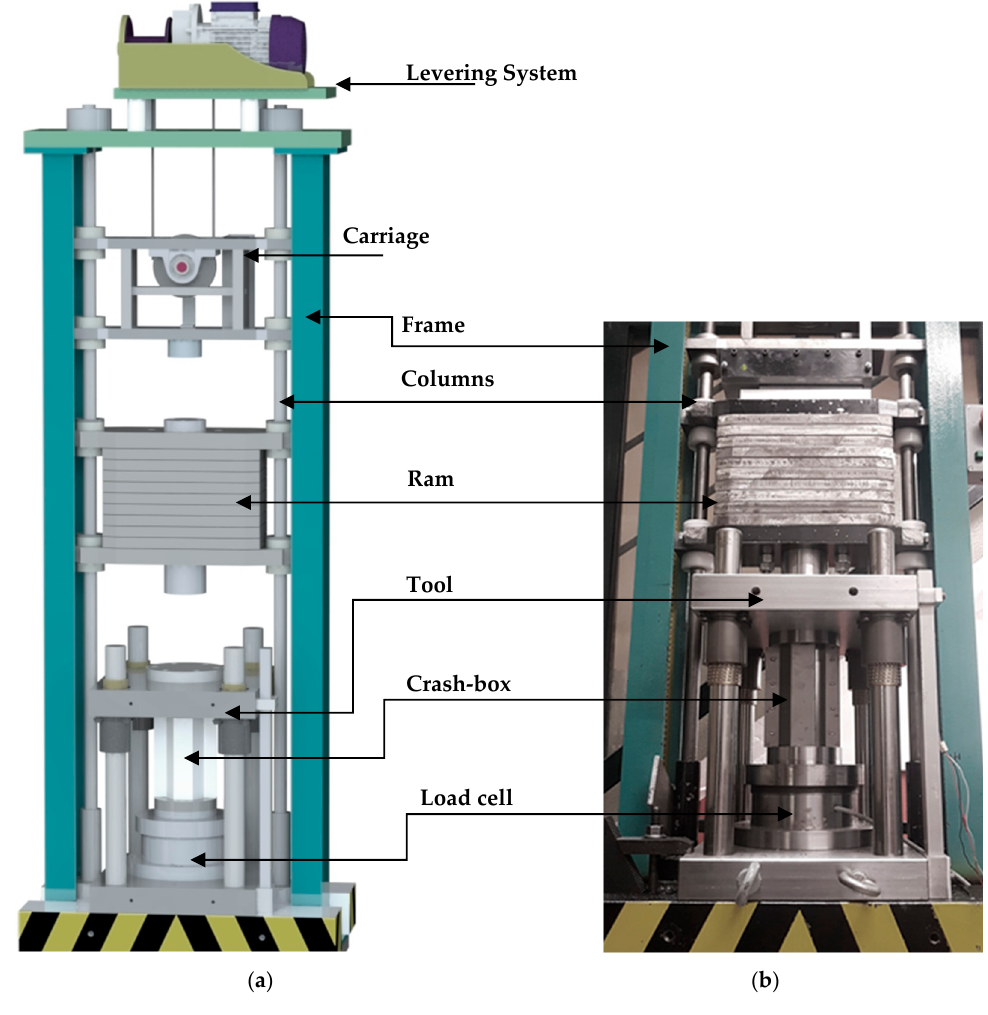
Figure 2. The drop weight testing machine: ( a ) schematic representation and identification of its main components; ( b ) photograph of the tool utilized in the crush tests.